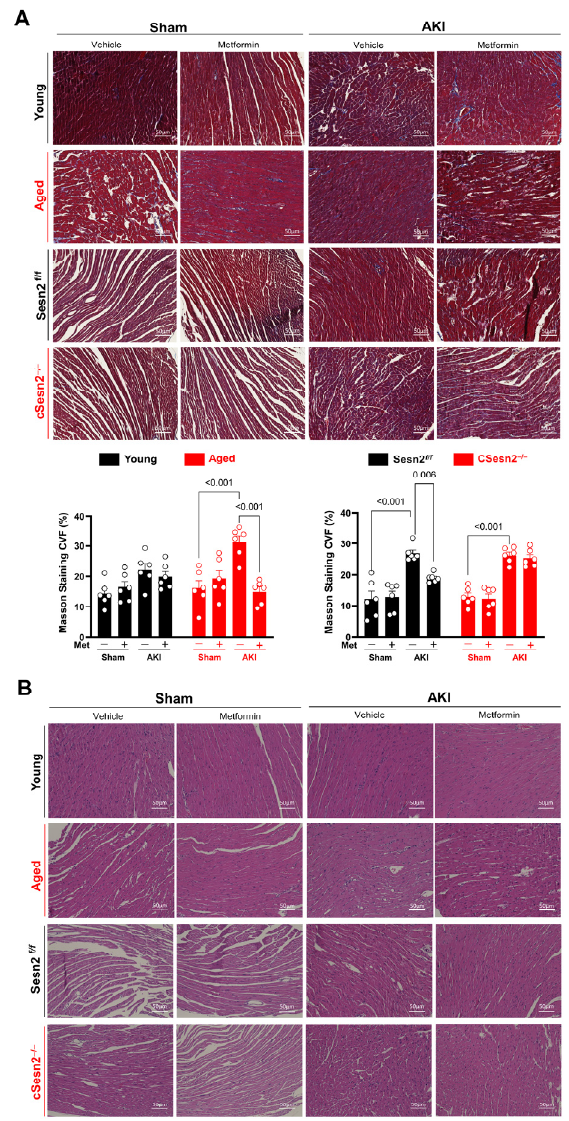
Figure 5. Effects of AKI and metformin on the development of cardiac cellular and fibrotic damage. ( A ) Representative Masson’s trichrome staining and percent collagen volume fraction (CVF). Means ± SEM; n = 6 per group. ( B ) Representative hematoxylin and eosin staining.